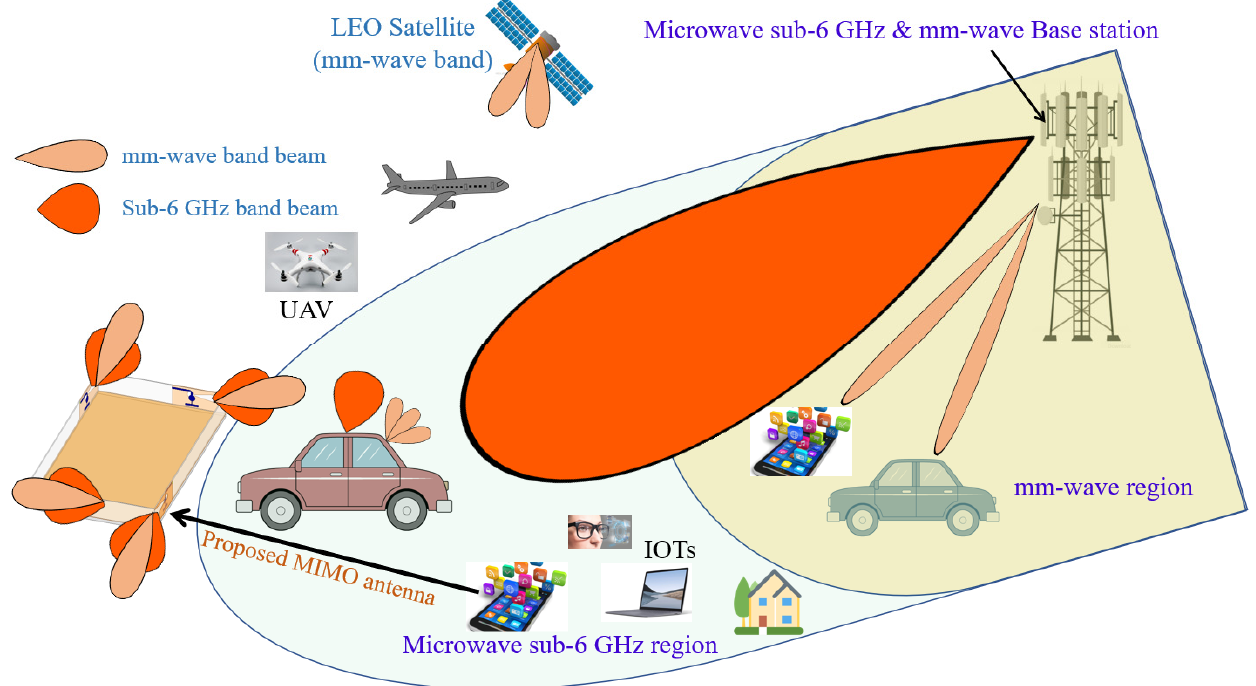
Figure 1. Integrated Sub-6 GHz and mm-wave bands IOT-based communication system and potential utilization of the proposed MIMO antenna design.